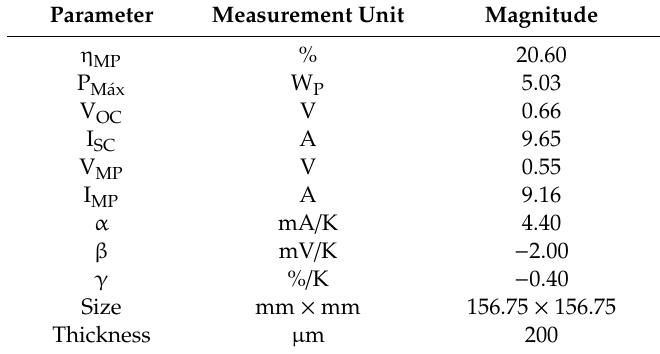
Table 1. Solar Cell Neo Solar Power ® NS6WL-2060 Datasheet. Reprint with permission [45]; 2018; Neo Solar Power NSP.